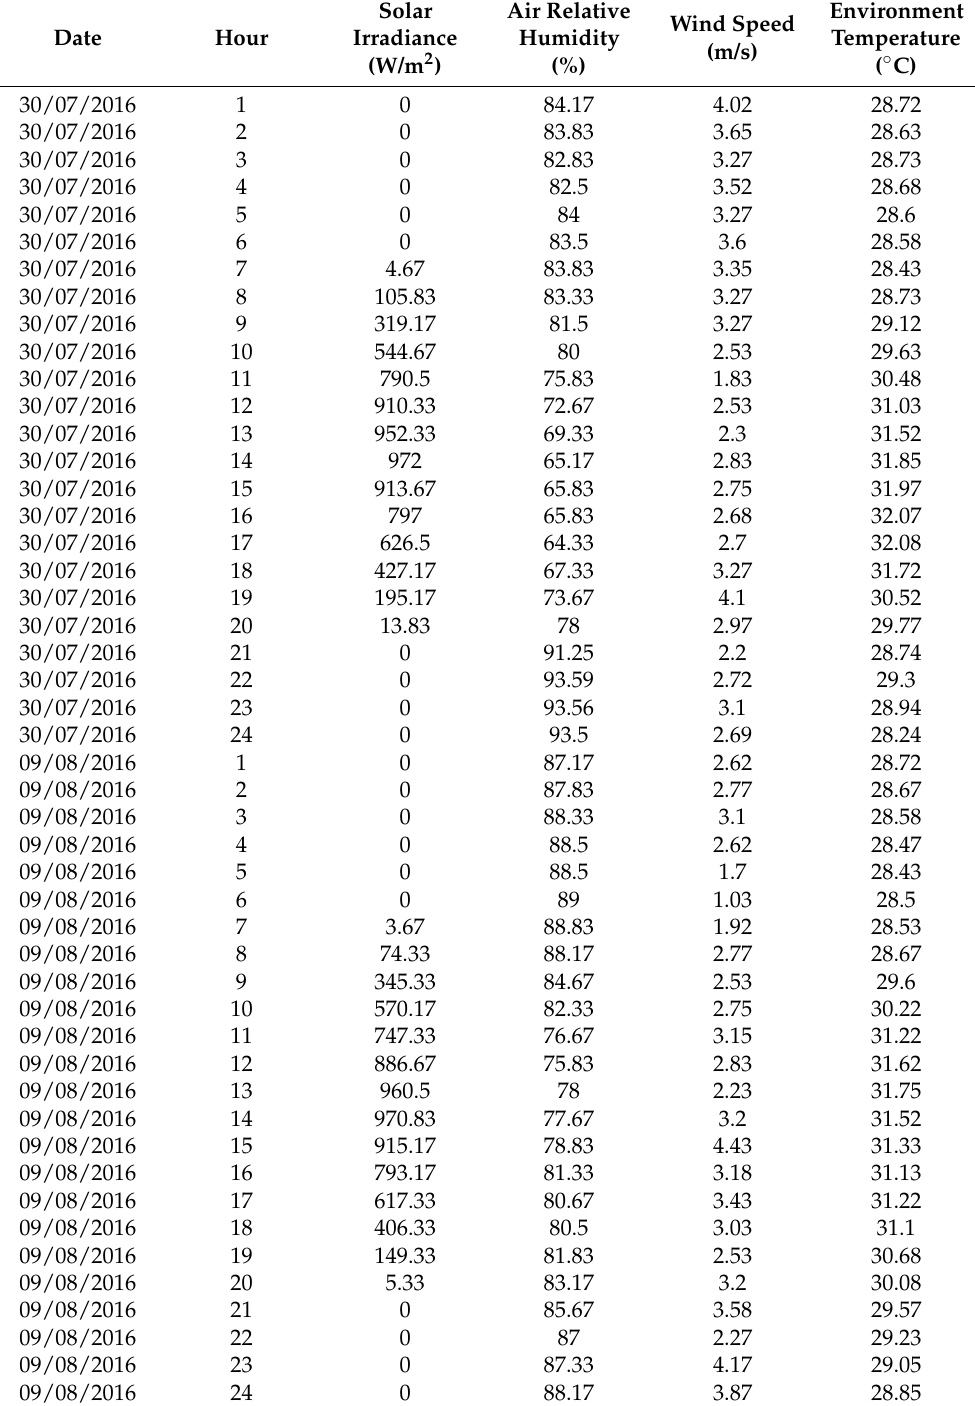
Table 5. Operating conditions of the GAHE, Chetumal Quintana Roo (30 July 2016 and 9 August